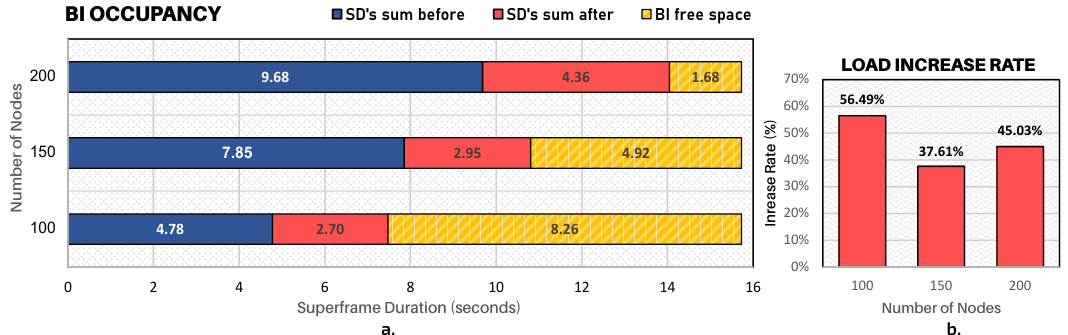
Figure 17. Ratio between load imposed and the behaviour of structures: ( a ) the load consumed and the free space within BI; ( b ) load increased percentage caused by